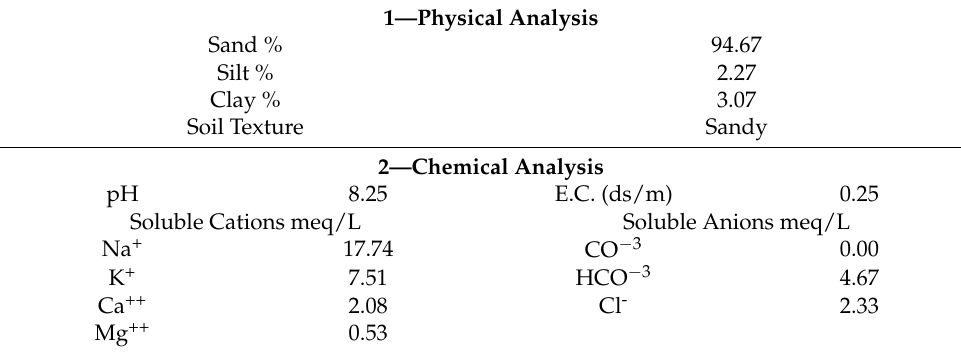
Table 1. Physical and chemical properties of the experimental